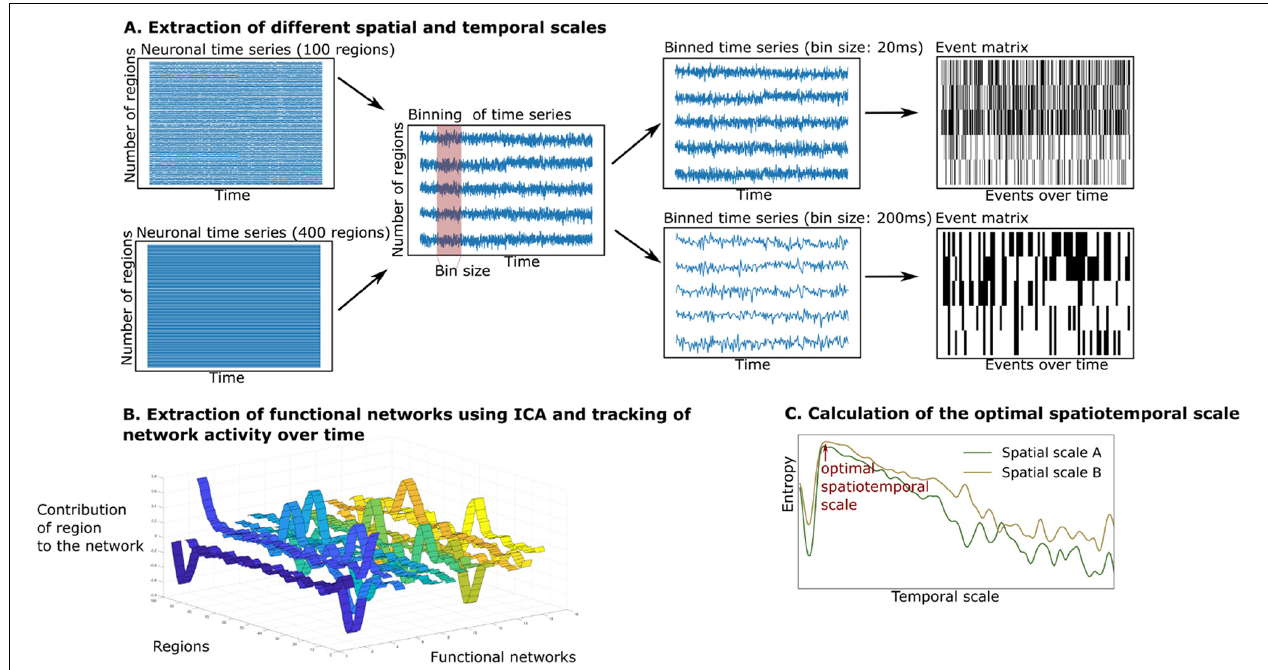
FIGURE 2 | Extraction and tracking of whole-brain functional networks at different spatial and temporal scales using the whole-brain model. (A) We simulate neuronal time series at different spatial scales (from 100 to 400 regions). We then create different bin sizes of the time series (using bins from 10 to 3,000 ms), the bin size corresponds to the temporal scale. The binned time series are binarized using a point process paradigm, resulting in an event matrix. (B) We extract whole-brain functional networks using independent component analysis, resulting in a network matrix (see ribbon plot). These networks are tracked over time by projecting the event matrix onto the networks, resulting in an activity matrix (not displayed). (C) The richness of the switching between functional networks is estimated by calculating the entropy of their switching probability. The entropy is compared across spatial and temporal